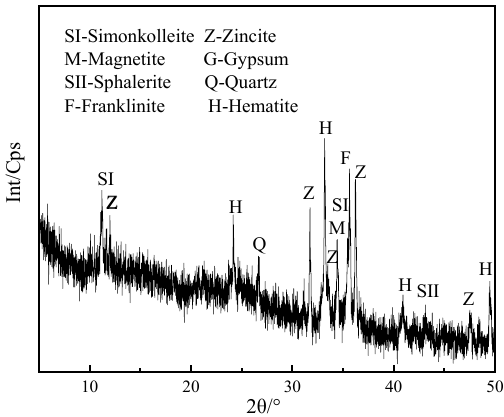
Figure 2. XRD analysis of the zinc-bearing dust sludge.